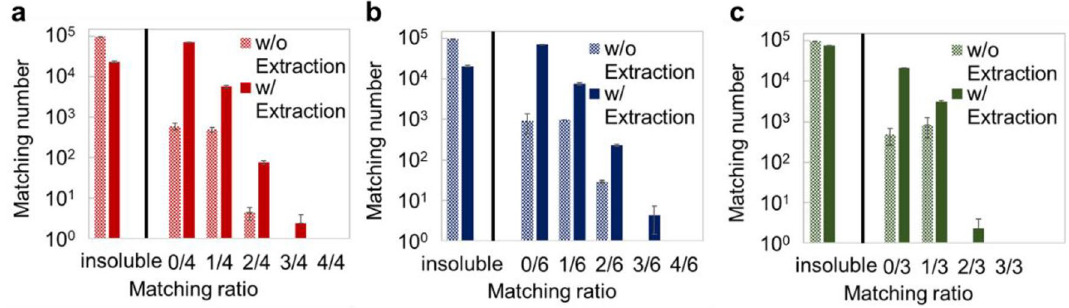
Figure 5. Estimation results with CNNWs. Prediction results for untrained article. (a ) No. 46, ( b ) No. 180, ( c ) No. 39. Insoluble means AI was unable to propose function-fulfilling structures. Others showed function- fulfilling structures with different matching ratios between AI output and the untrained film’s